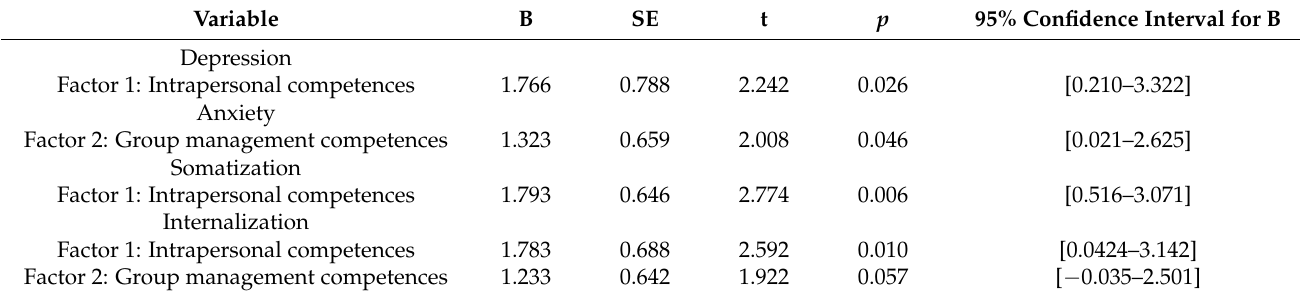
Table 4. Selected linear regression models: the influence of trainer competences on adolescent symptoms. Variable